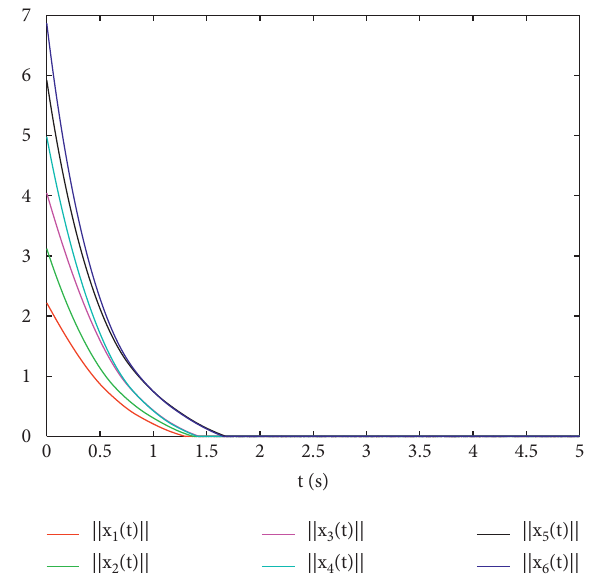
Figure 1: Time evolution of ‖ z